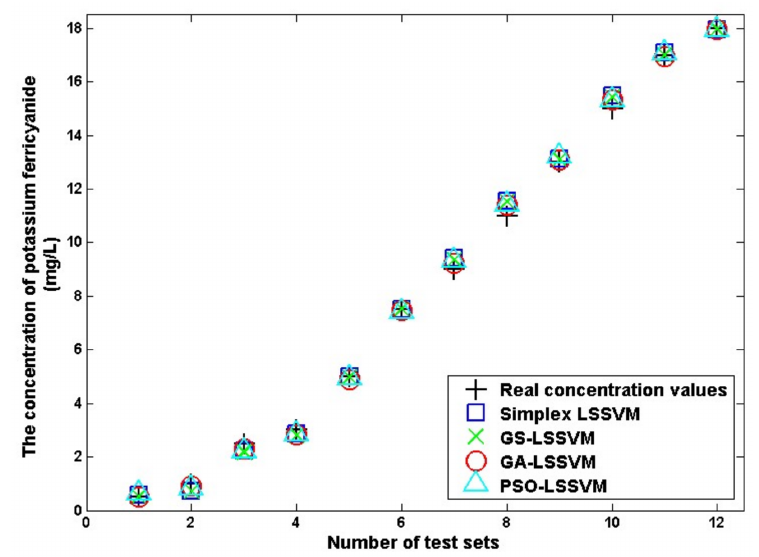
Figure 6. Illustration of comparison between real value and prediction value based on four parameter optimization